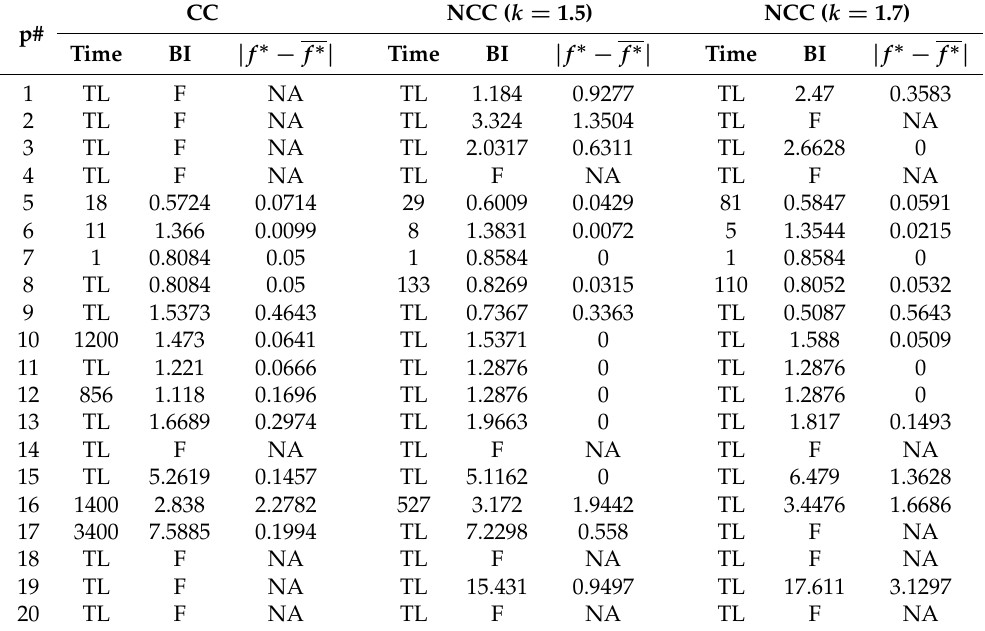
Table 4. Results of solving MILP problems produced by CC and NCC models using 7